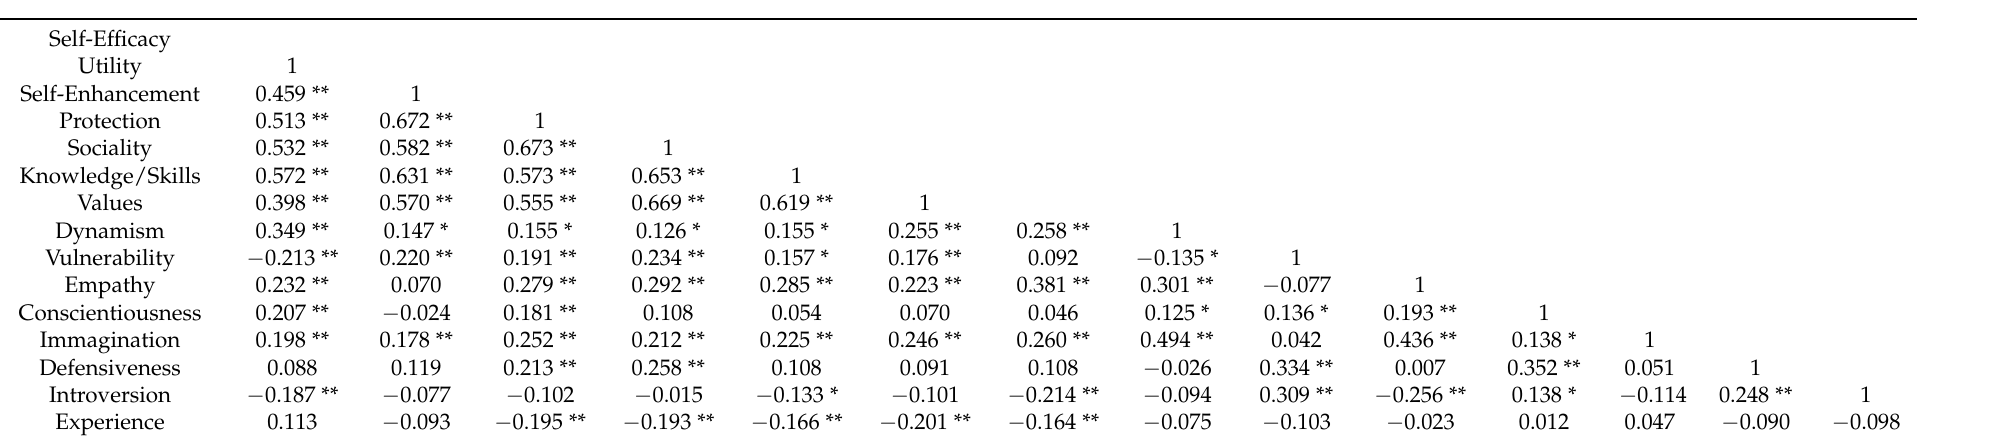
Table 3. Bivariate